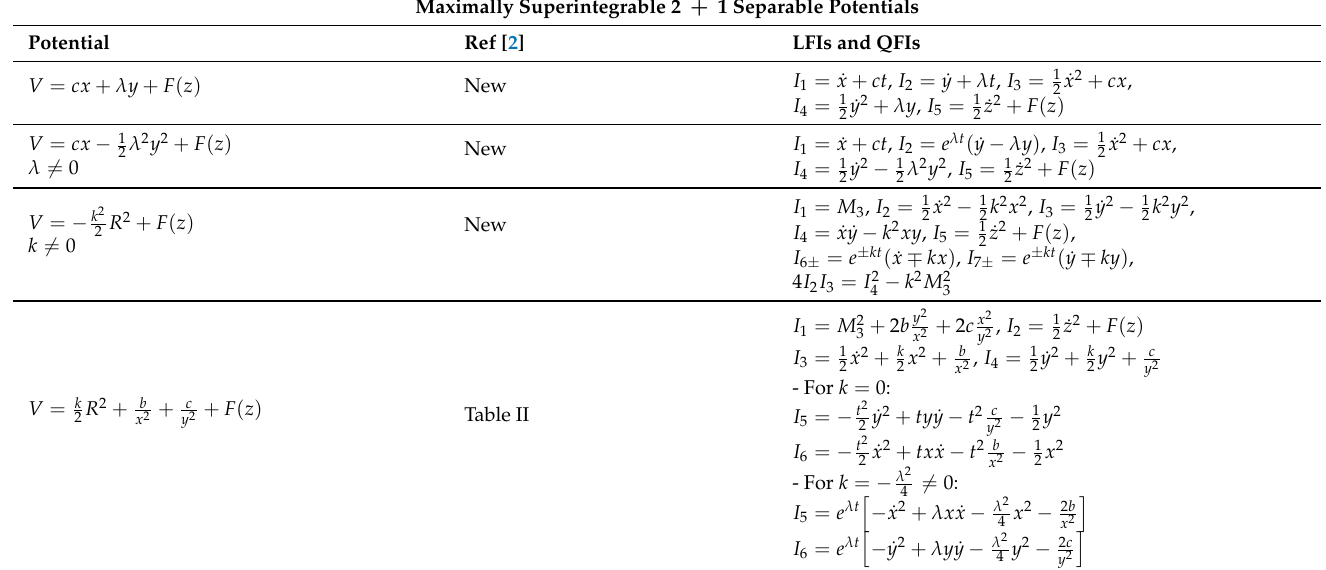
Table 3. Maximally superintegrable potentials V ( x , y , z ) = Φ ( x , y ) + F ( z ) in E 3 , where Φ ( x , y ) are superintegrable potentials in E 2